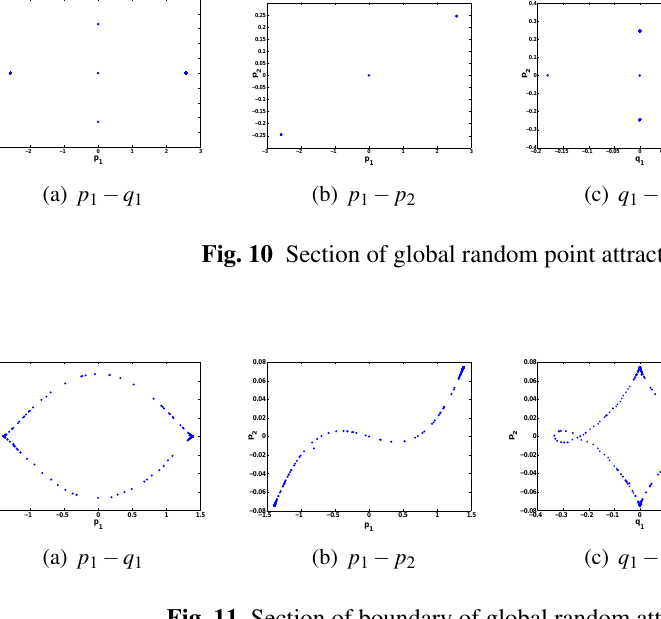
Fig. 11 Section of boundary of global random attractors for ϕ NGM 3 with case